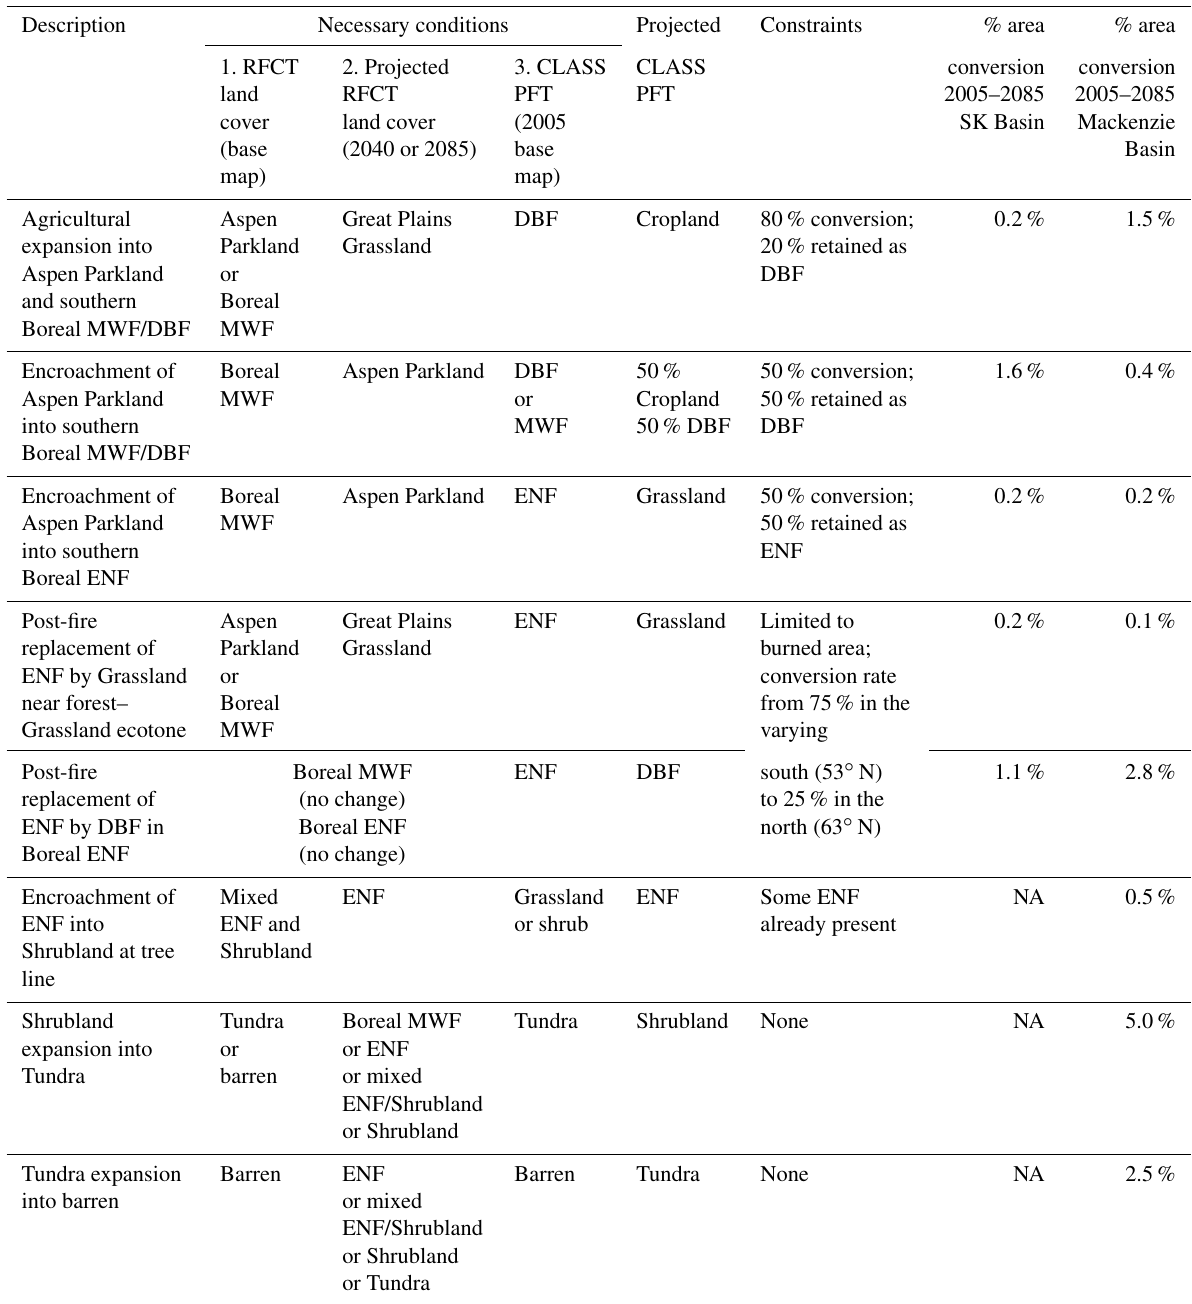
Table A1. Projecting future changes in the MESH land cover map over the 21st century: changes in the MESH plant functional types (PFTs); changes in the RFCT land covers that were used to identify areas of change; and the associated conditions and constraints. The changes were implemented separately for each MESH grid square, when all three necessary conditions (1–3) and the associated constraints were